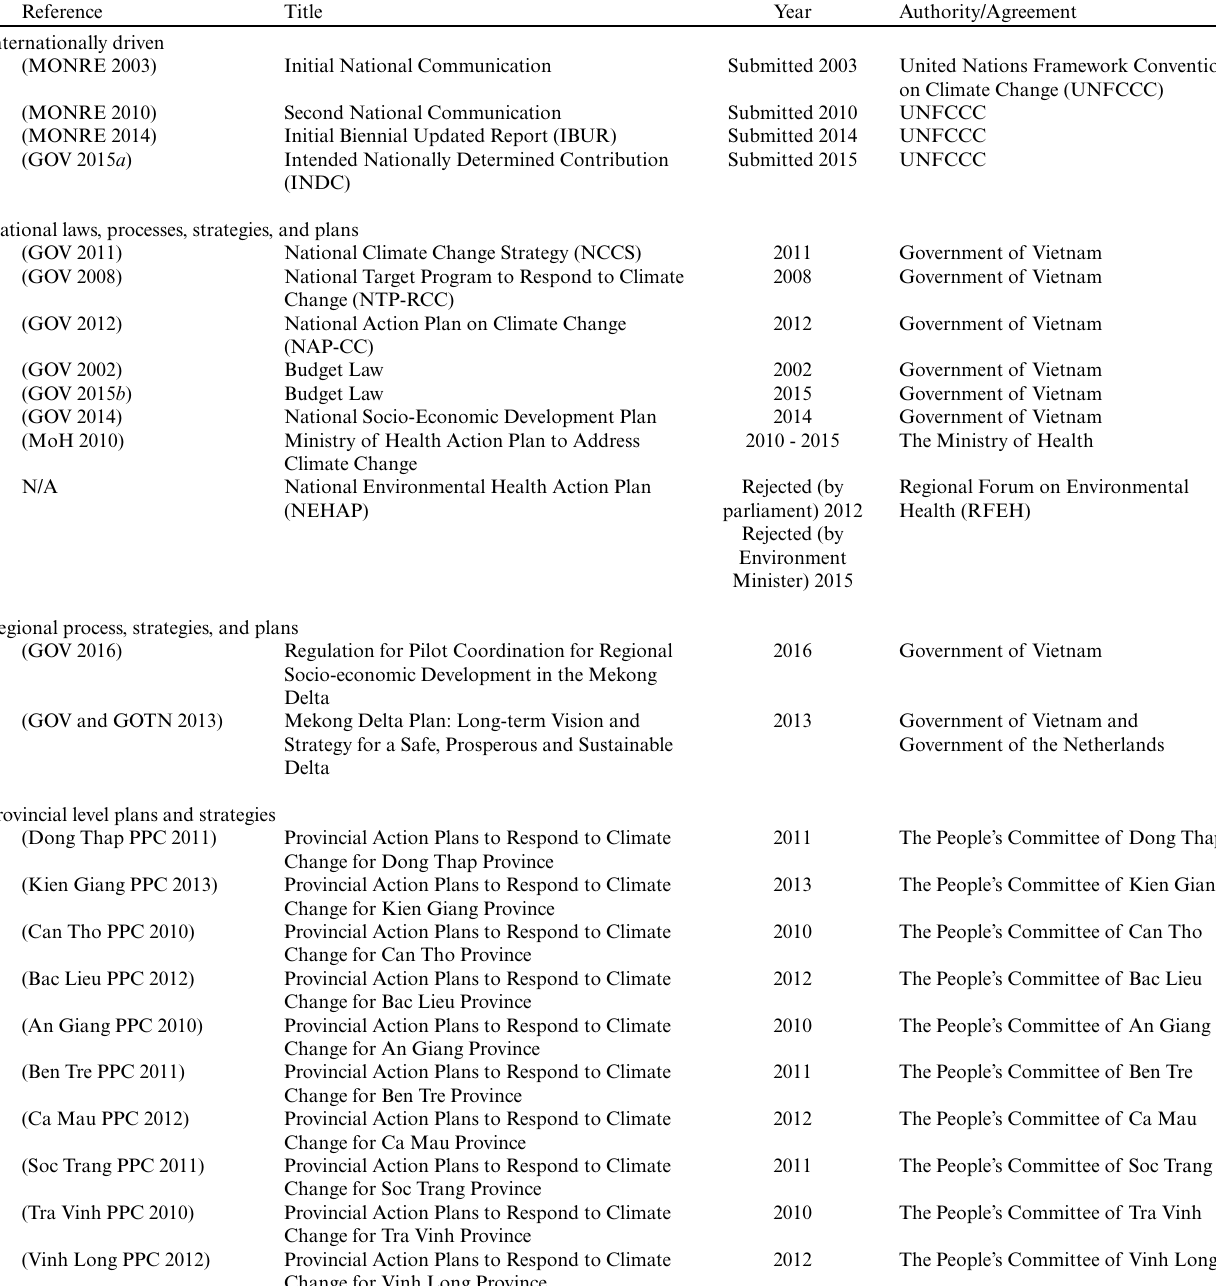
Table 2 . Adaptation and health-related laws, processes, agreements, strategies, policies, and